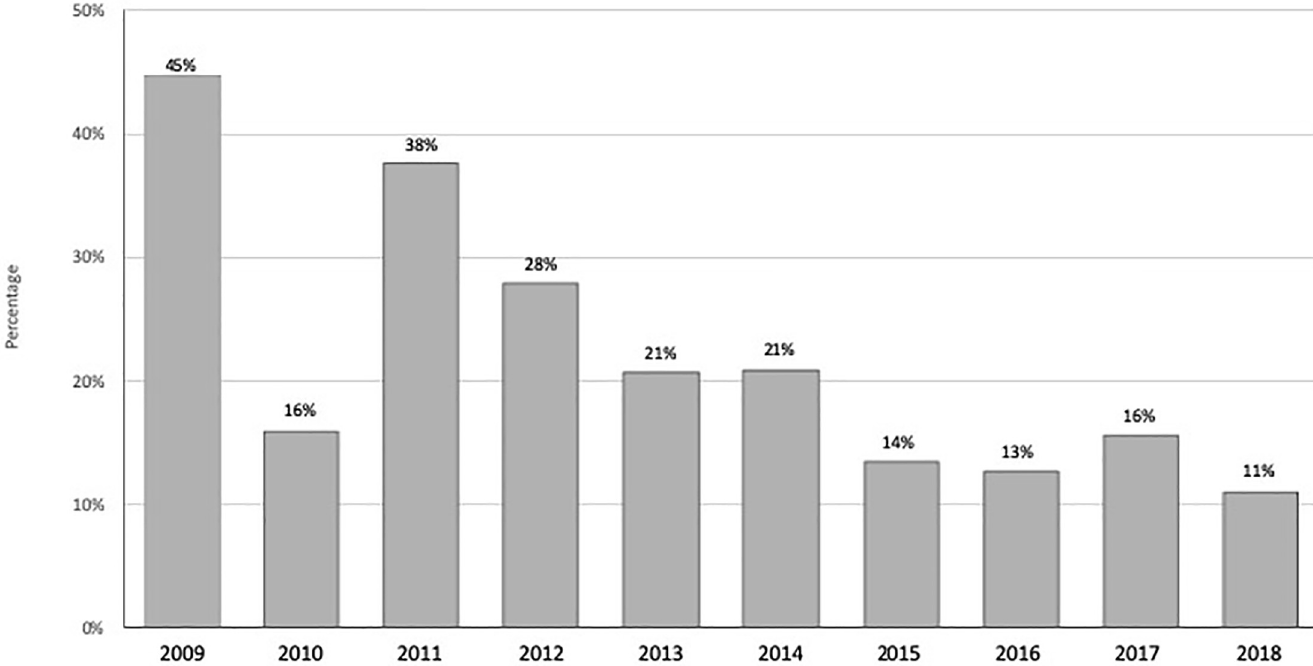
Fig 2. Frequency of people with detectable levels of 137 Cs from 2009 to 2018. The frequency of people with detectable levels declined steadily during the study, with moderate fluctuations.